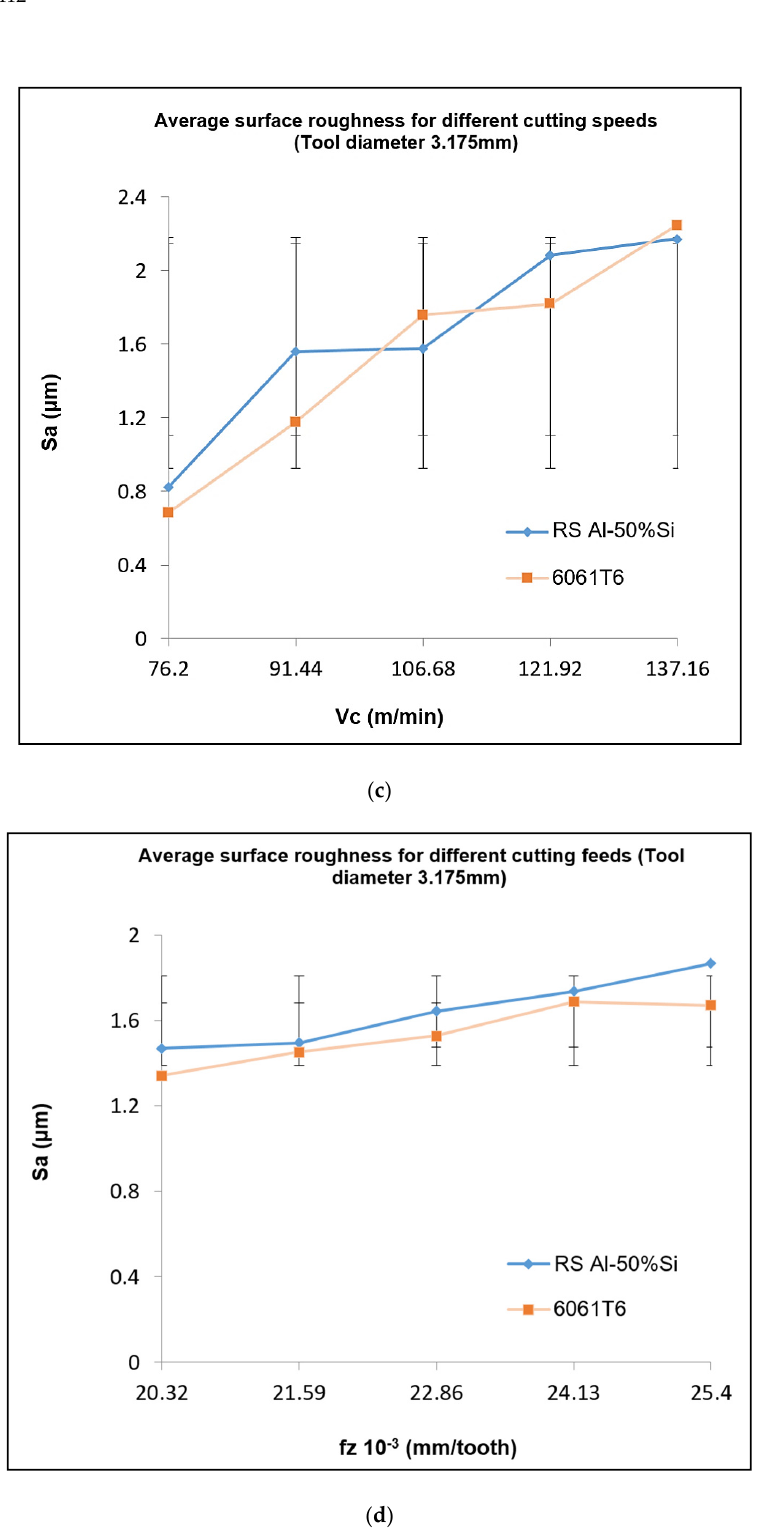
Figure 12. Average arithmetic roughness plots ( a ) at varying speeds for tool T1, ( b ) at varying feeds for tool T1, ( c ) at varying speeds for tool T3, ( d ) at varying feeds for tool T3